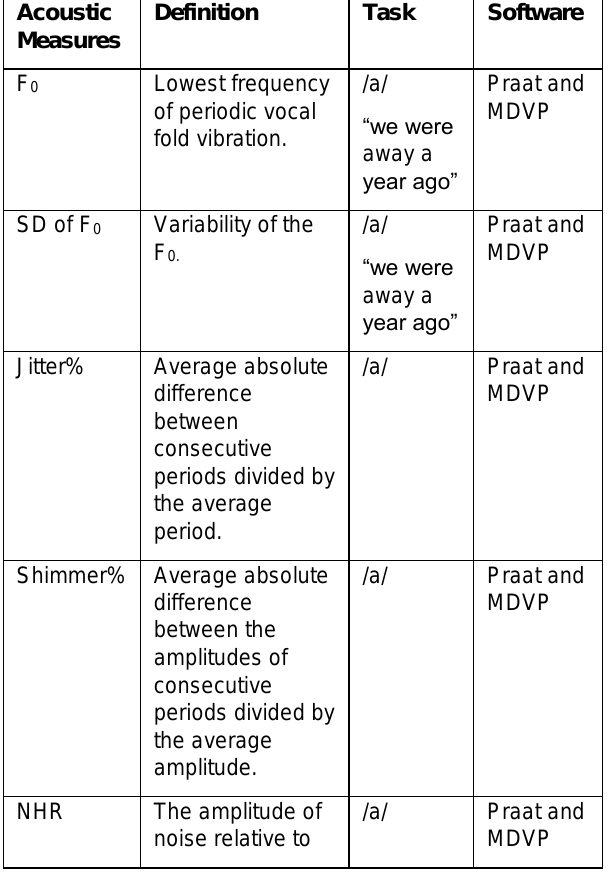
Table 1. Acoustic Measures, Definition, Task, and